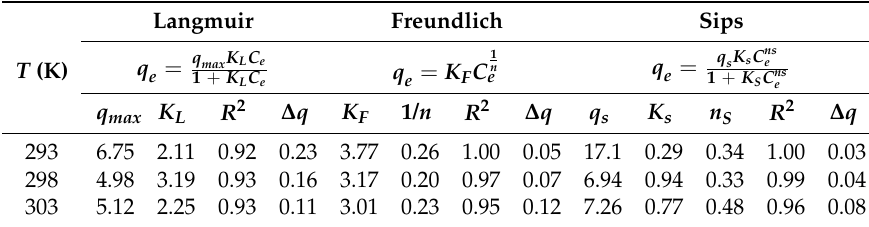
Table 3. Calculated isotherm parameters via nonlinear